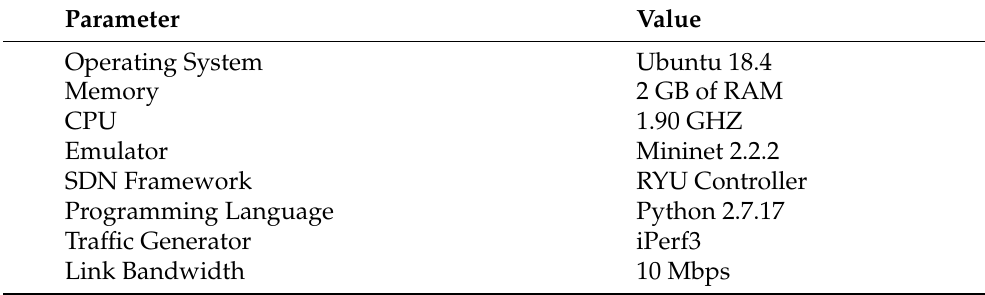
Table 1. Emulation Parameter Values.